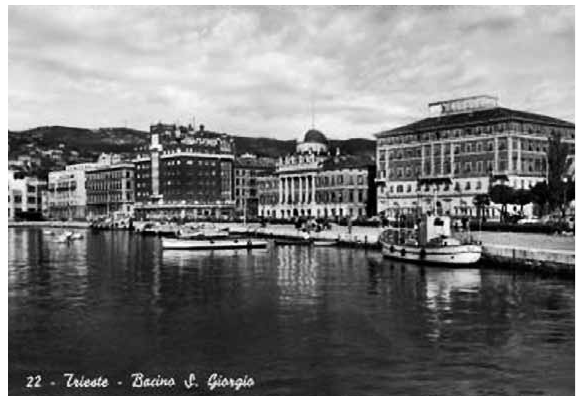
fig. 1. Trieste’s coastline (photo by filippo